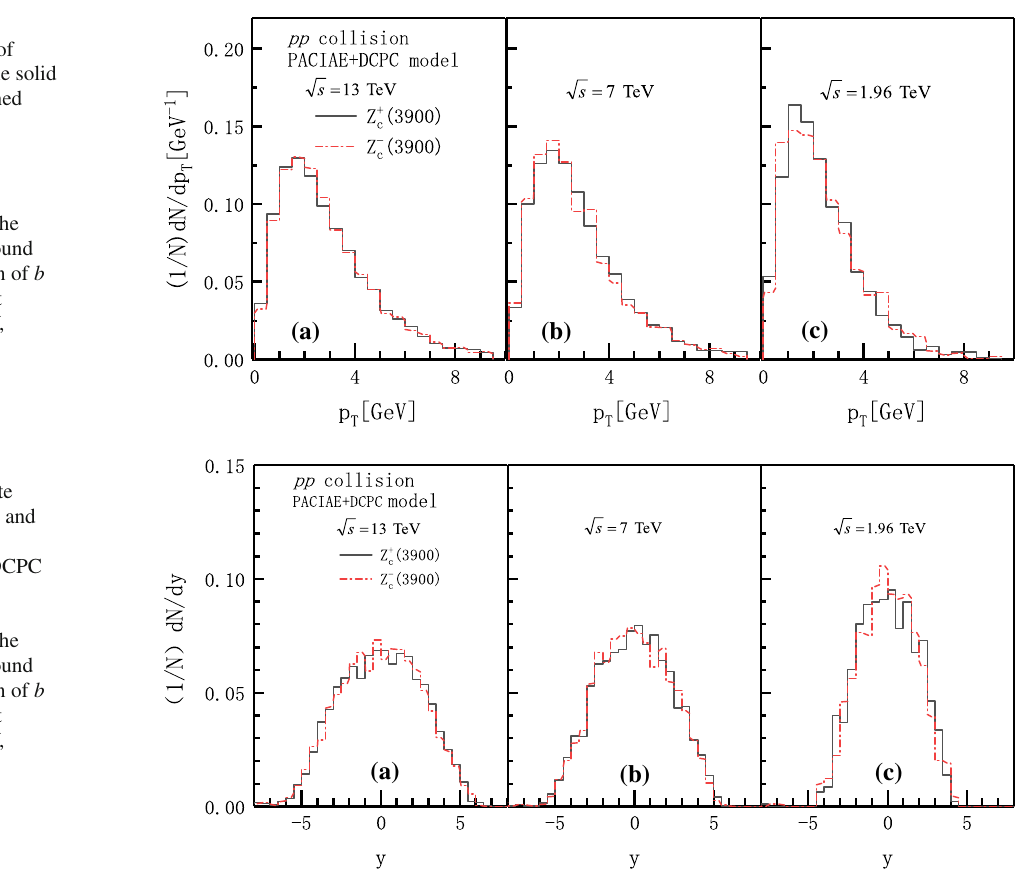
Fig. 4 The rapidity distributions of exotic state Z + c ( 3900 ) (the solid line) and Z − c ( 3900 ) (dashed line) calculated by PACIAE+DCPC model simulations with (cid:5) m = 14 . 1 MeV and R 0 = 1 . 74 fm, based on the Z ± c ( 3900 ) → J /ψπ ± bound state from the decay chain of b hadrons in pp collision at √ s = 1 . 96 , 7 and 13 TeV,